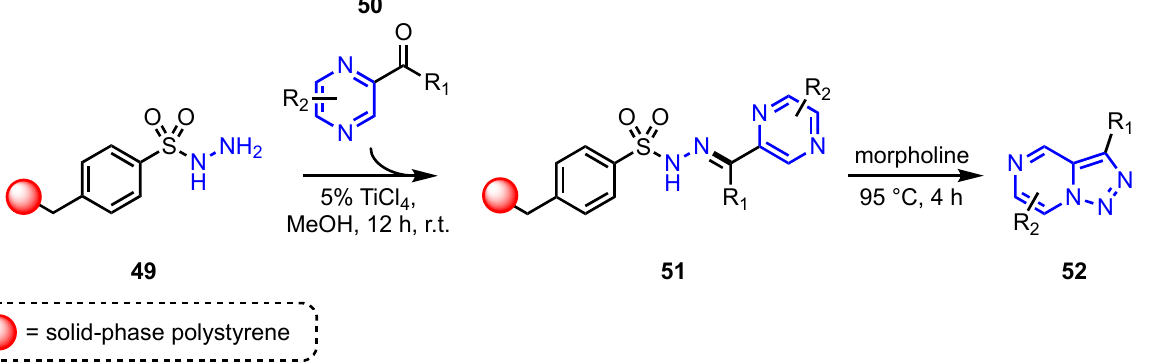
Scheme 11. Intramolecular cyclization of hydrazone 51 , derived from tosylhydrazide 49 , in the formation of disubstituted 1,2,3-triazolo[1,5- a ]pyrazines 52 . (R 1 , R 2 =